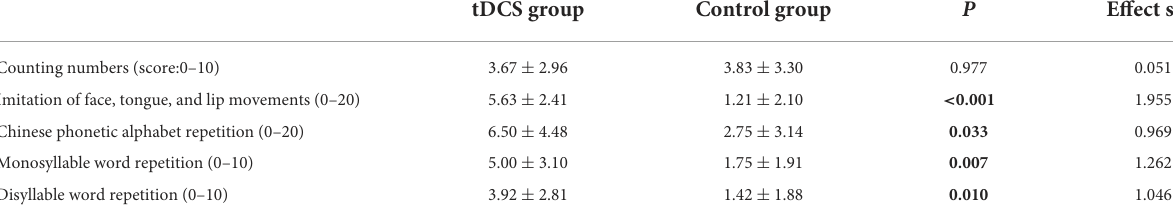
TABLE 3 Changes in speech-language performance between baseline and post-treatment of each group.